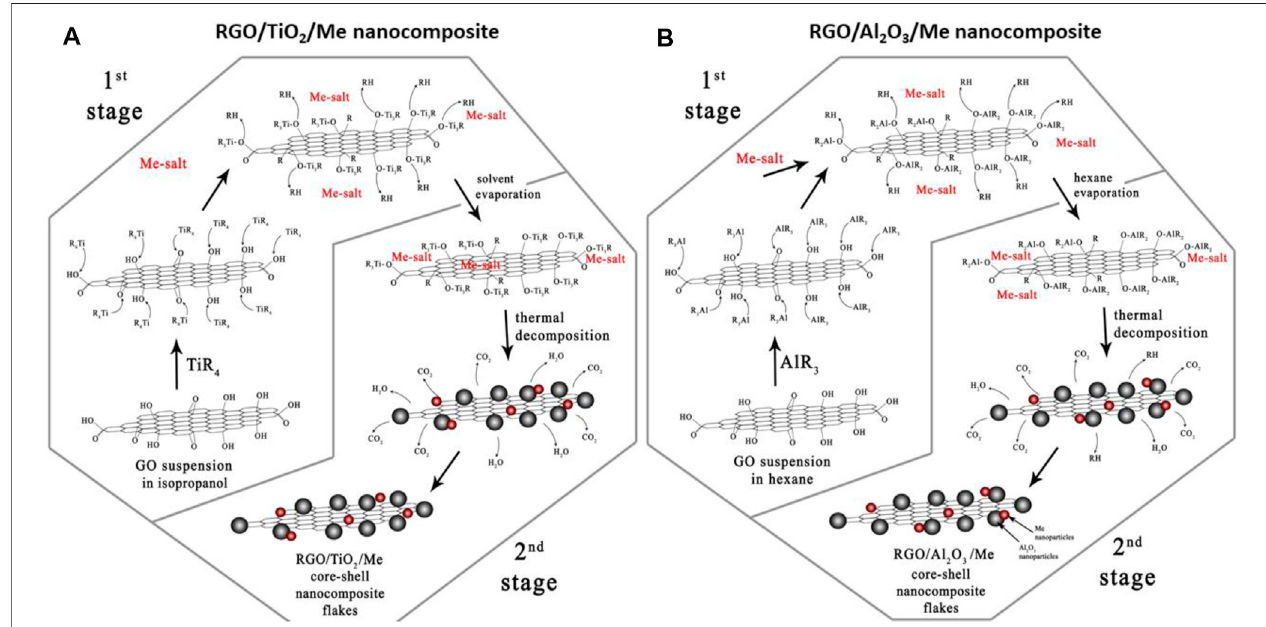
FIGURE11| Schematicrepresentationofthemechanismofcovalentmodi fi cationofGOsurfacewithTiO 2 -MenanoparticlestowardnanohybridRGO/TiO 2 -Me (A) and RGO/Al 2 O 3 -Me (B) composite systems, using the simpli fi ed sol-gel method (Reproduced with permission (Jastrzebska et al., 2017d), (Jastrze ˛ bska et al., 2016b),